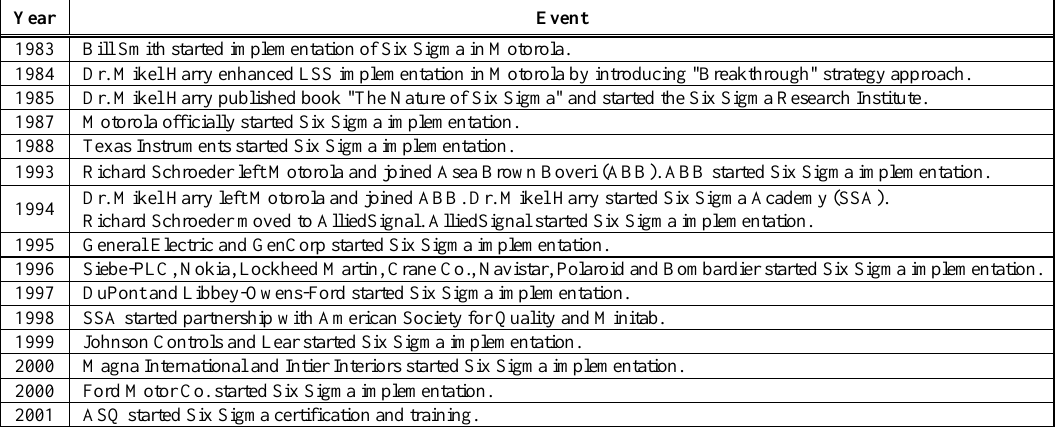
Table 1. An historical overview of the Six Sigma implementation in the automotive